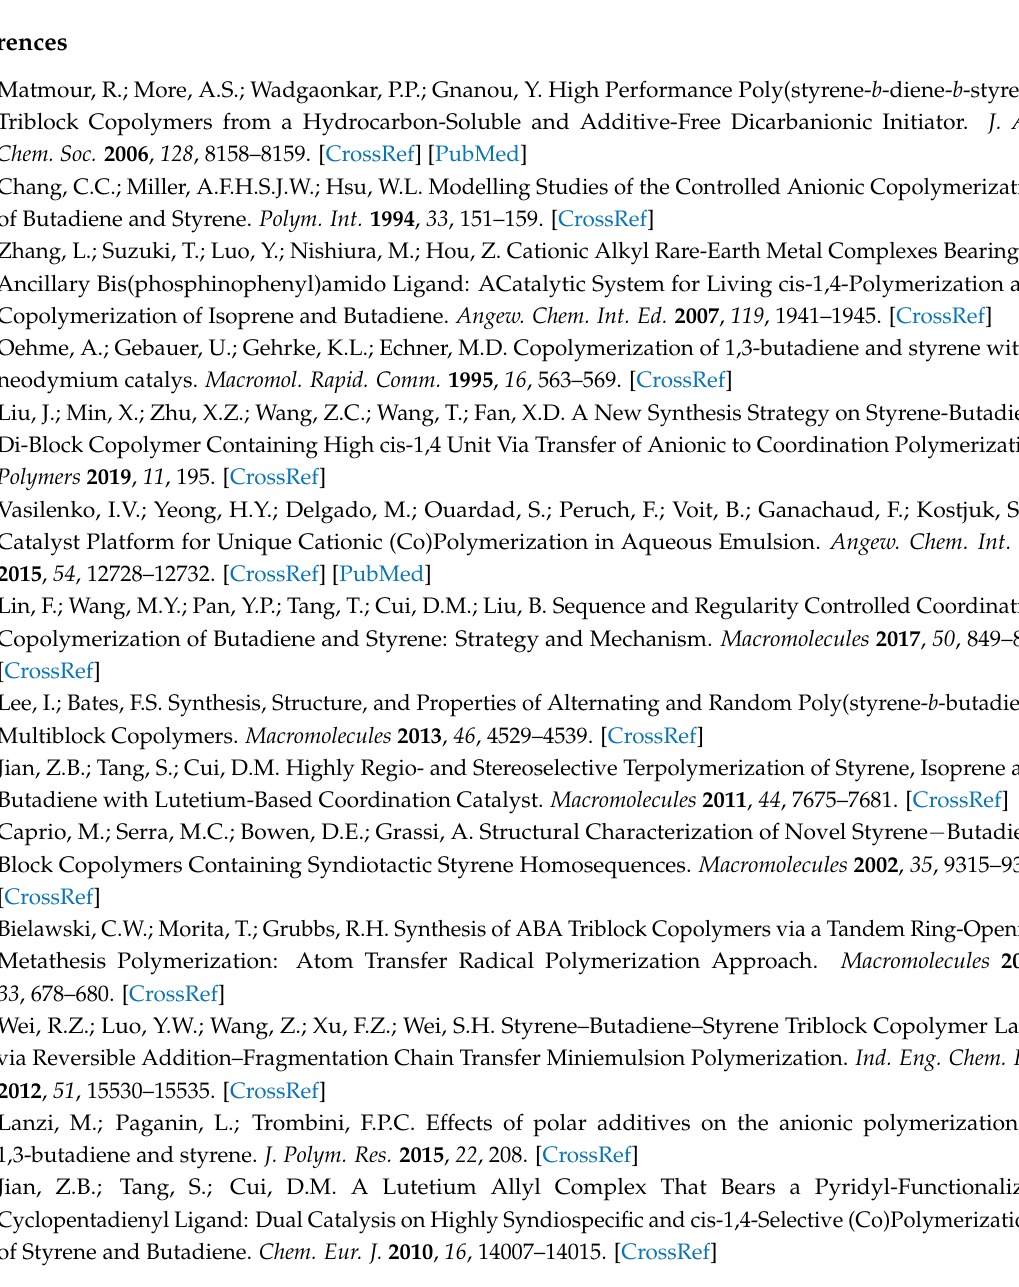
Figure S1. the 1 H-NMR of St polymerization process with different polymerization time; Figure S2. 1 H-NMR of Li/HO-SBS-OH; Figure S3. 13 C-NMR of Li/HO-SBS-OH; Figure S4. 1 H-NMR integral data of HO-SBS-OH; Figure S5. 13 C-NMR integral data of